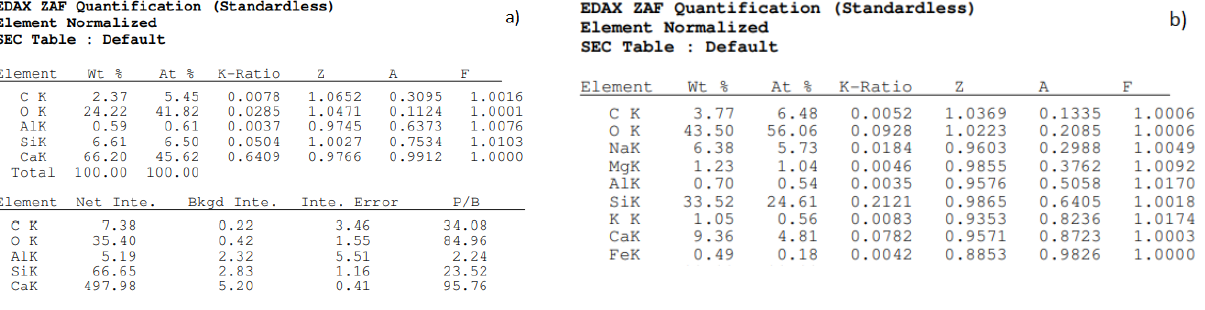
Figure 16. Elementary composition of silicate brick (SEM); ( a ) traditional (reference sand-lime brick 90% QS); ( b ) glass sand modified by 90%.